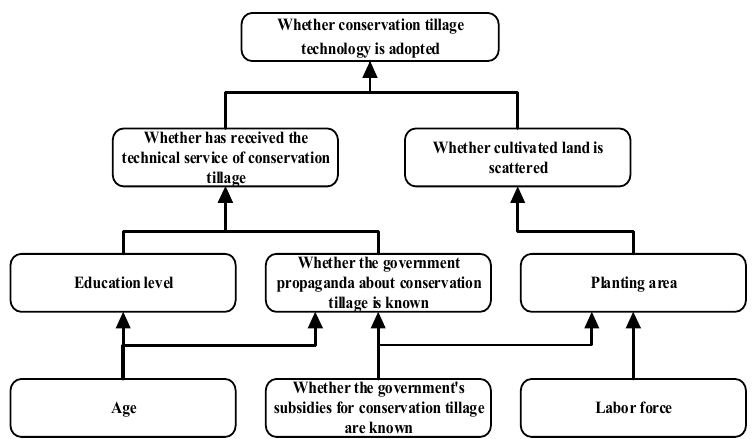
Figure 1. Interpretative structural model of the influencing